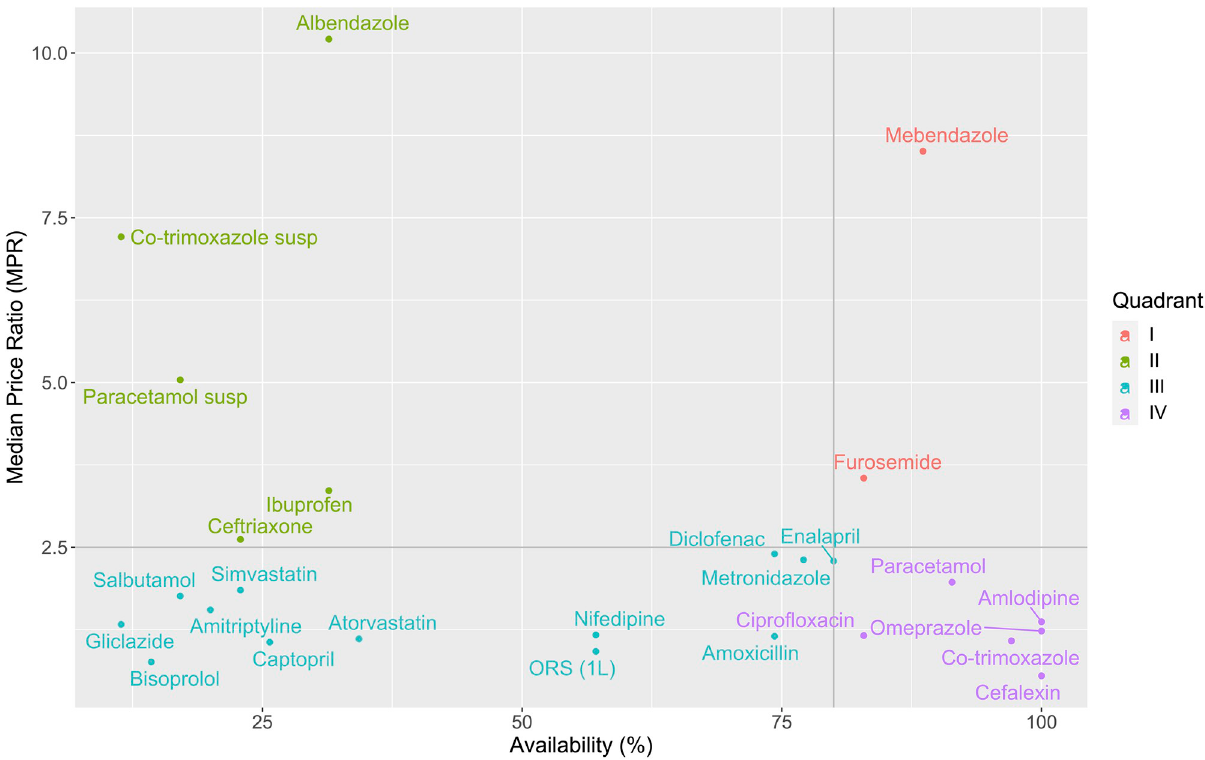
Fig 2. Comprehensive analysis of the availability and prices of LPGs in the private sector. Horizontal line: MPR = 2.5, Vertical line: Availability = 80%, susp: suspension.